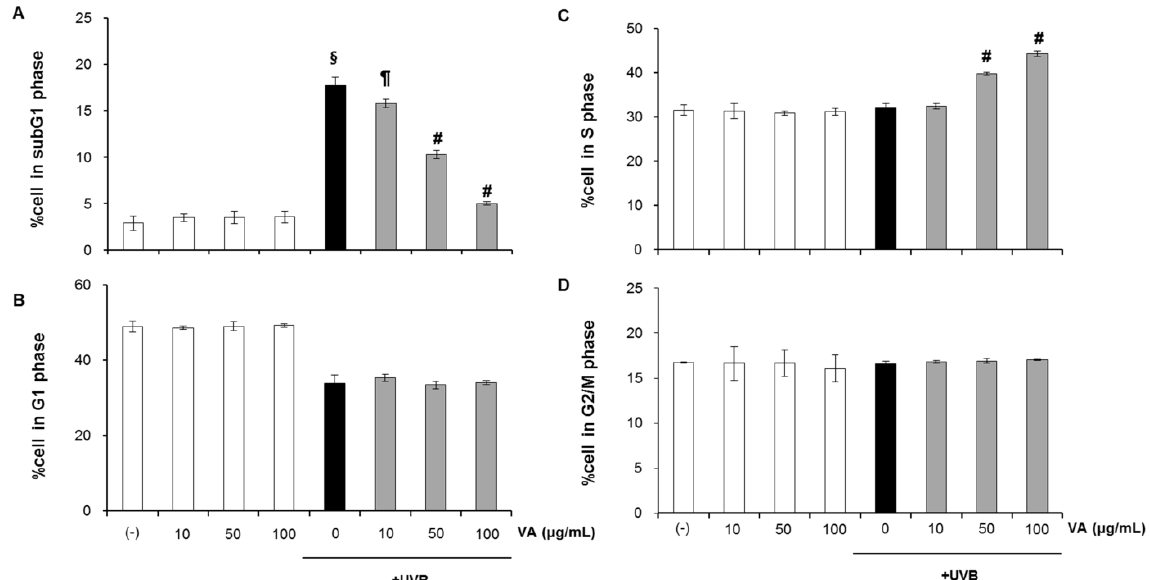
Figure 4. Accumulation of HaCaT cells in S phase following veratric acid treatment. The percentage of cells in the ( A ) subG1, ( B ) G1, ( C ) S, ( D ) G2/M phase.